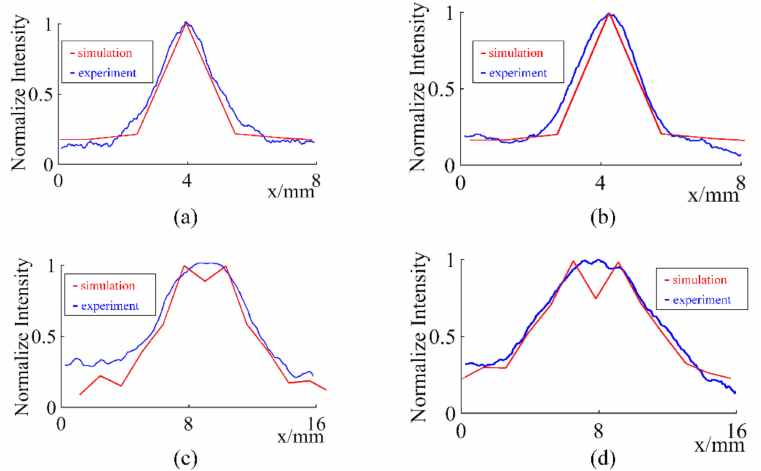
Figure 6. Comparison of simulated (red) and experimental (blue) left ( a , c ) and right ( b , d ) horizontal cross-section of spots intensity distributions at viewing angles of 8 ◦ and 16 ◦ . Red: Simulation; and blue: